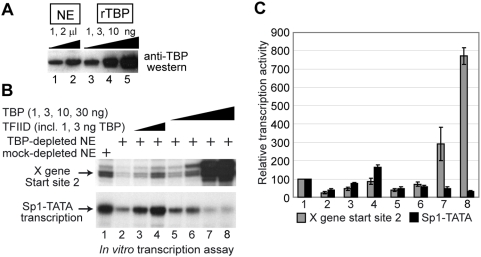
Transcription from X mRNA Start site 2 can use either a free TBP or the TFIID complex.(A) Examination of TBP concentration in HeLa NE. Indicated amounts of HeLa NE and purified recombinant TBP were loaded on a SDS-PAGE gel, and TBP was detected by anti-TBP western blotting. (B) In vitro transcription assays of the X gene (from Start site 2) and the Sp1-TATA templates (in a single two-template reaction). Control (lane 1) or TBP-depleted (lanes 2–8) NEs were tested for X gene or Sp1-TATA transcription in the absence (lane 2) or presence of 1 µl (lane 3) or 3 µl (lane 4) of purified TFIID or the presence of 1 ng (lane 5), 3 ng (lane 6), 10 ng (lane 7), or 30 ng (lane 8) of purified recombinant TBP (1 µl of the TFIID used in this experiment contained about 1 ng of TBP [6]). The enhancer-X promoter template was used to measure transcription from Start site 2. (C) Quantification results of the transcription assay. Transcription assays were performed twice for the reaction with 30 ng TBP (lane 8 of panel A) and four times for all of the other reactions. Brackets show standard errors of means.